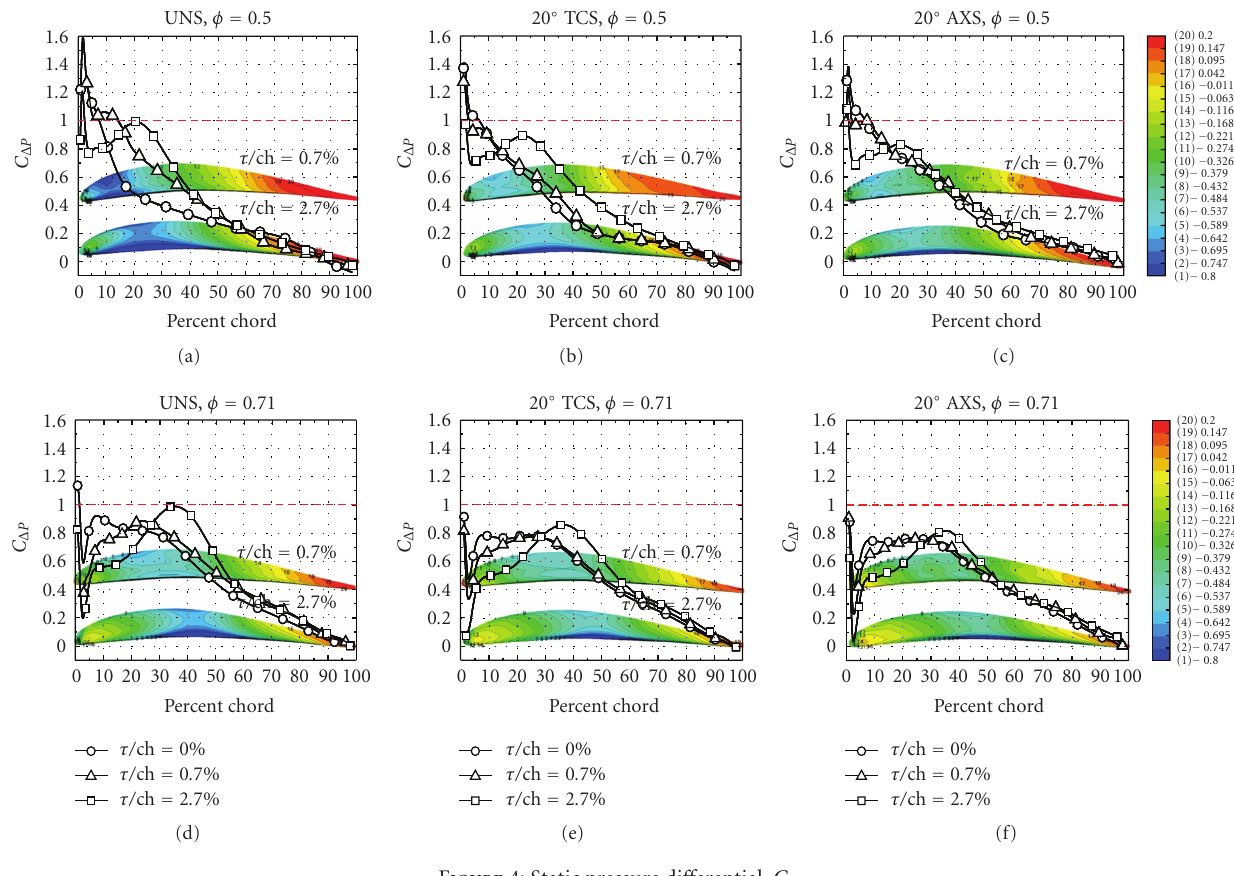
Figure 4: Static pressure di ff erential, C Δ P